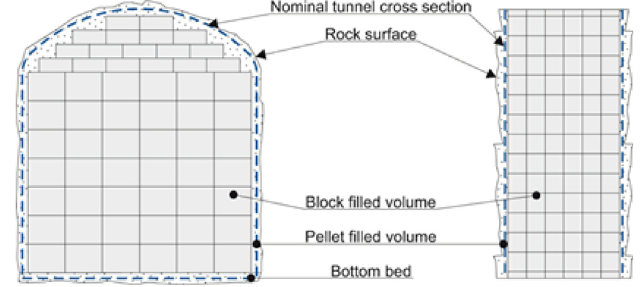
Fig. 3. KBS-3 Tunnel back fi